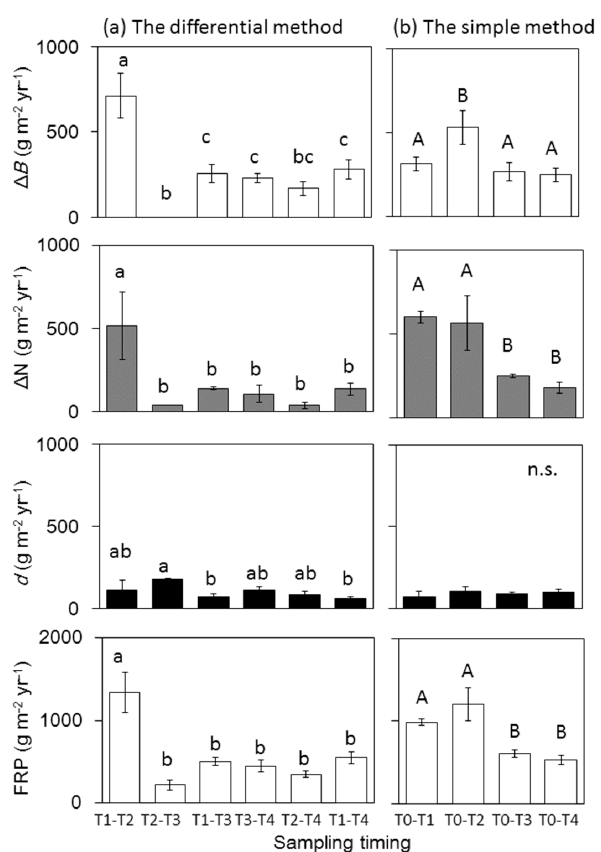
Figure 4. Fine root biomass ( ∆ B), fine root necromass ( ∆ N), decomposed dead fine roots (d) and fine root production (FRP) over various sampling times using ( a ) the differential method and ( b ) the simple method. Different letters indicate significant differences among sampling times ( p < 0.05). Note that, as ∆ B between T2 and T3 were negative, they were assigned as zero, because negative values are not possible in ecology [9]. Forests 2019 , 10 , x FOR PEER REVIEW